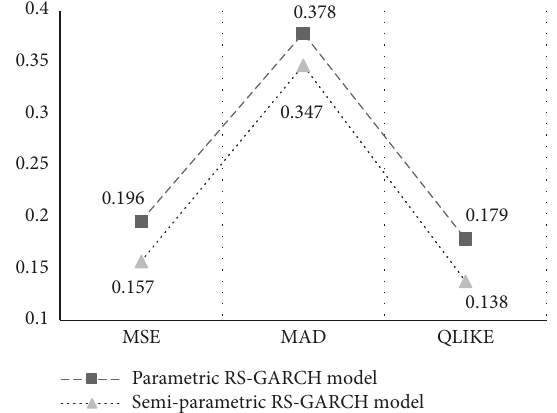
Figure 10: The model fitting error results out of sample period (CSI